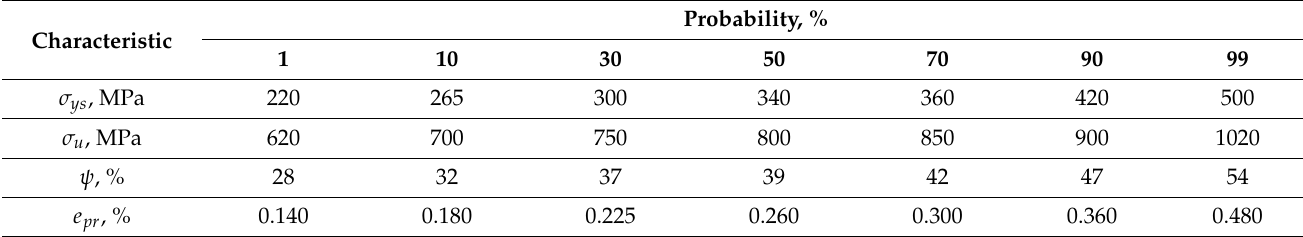
Table A2. Probabilistic values of mechanical characteristics for steel C45.